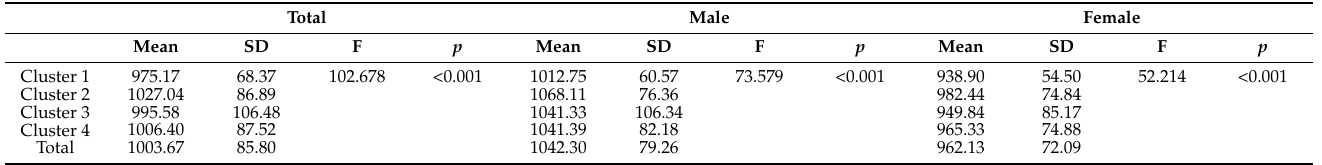
Table 4. Distributional analysis of metabolism by physical fitness